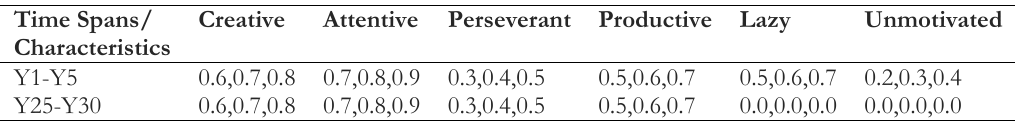
Table 3. The change in the values of fuzzy membership degrees for candidate 5 during the first and last time spans.